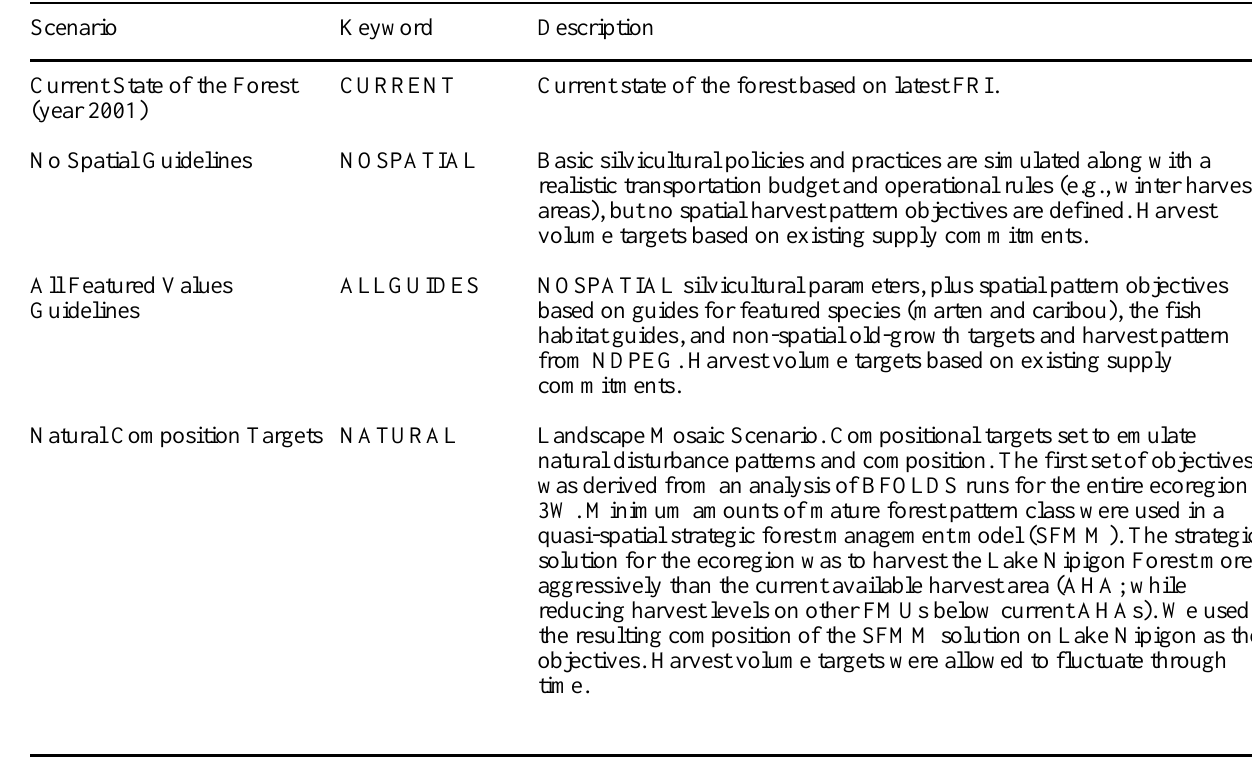
Table 2. Description of the four conditions (current forest and three management scenarios) used in the scenario